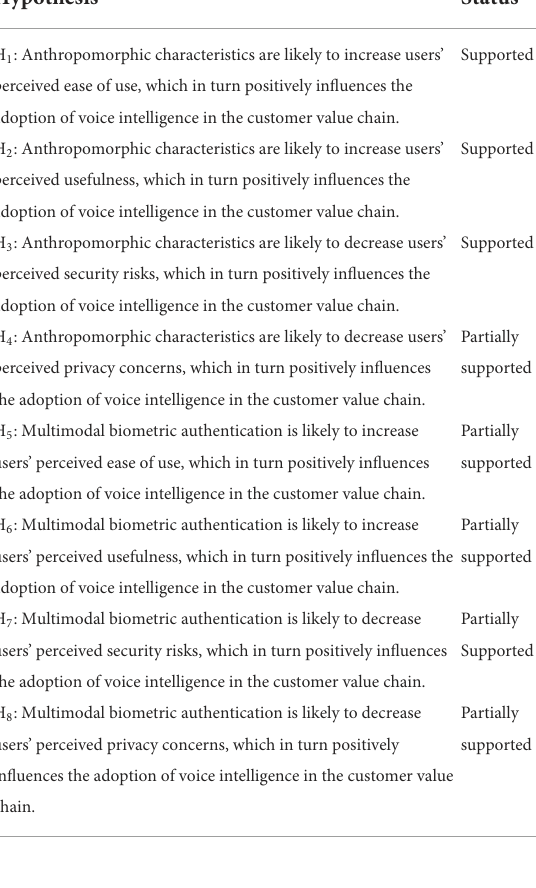
TABLE 10 Validation of the hypotheses.